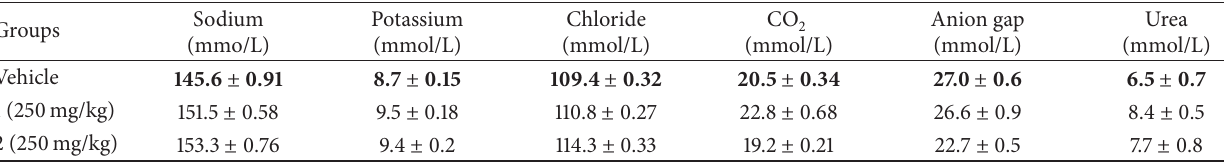
Figure 17: Histological sections in acute toxicity test (H&E staining, 20x). Histological sections of liver (first row) and kidney (second row). Untreated mices (control group) received 5mL/kg vehicle (5% Tween 20) ((a) and (d)). Animals treated with 250 mg/kg are ((b) and (e)) and ((c) and (f)) for compounds 1 and 2, respectively. There are no significant differences in structures of liver and kidney between treated and control group. Table 4: Effects of 250 mg/kg of 1 and 2 on renal function